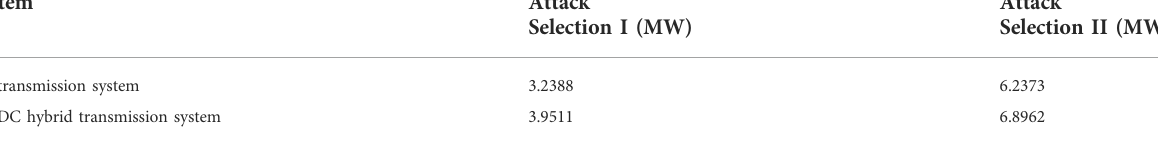
TABLE 7 System load shedding results.